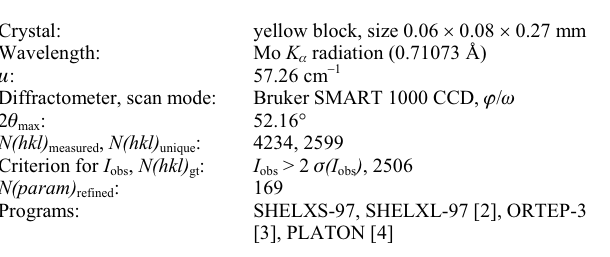
Table 1. Data collection and handling.